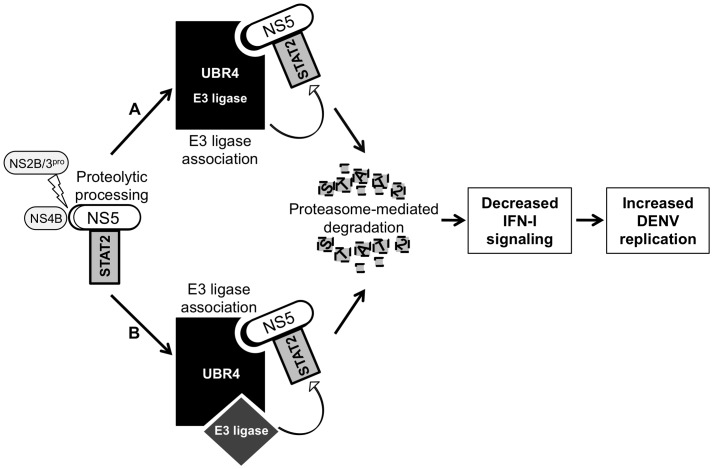
Model of DENV-mediated STAT2 degradation.NS2B/3 protease cleaves NS4B away from NS5 to yield proteolytically-processed NS5. Proteolytically-processed NS5 brings STAT2 into contact with the degradation machinery of the cell by binding UBR4. UBR4 may function as an E3 ligase (A), but as it lacks a known E3 ligase catalytic domain such as the HECT or RING, it may instead act as the recognition component or scaffold of an E3 ligase complex (B). STAT2 degradation prevents the establishment of an antiviral state thereby allowing DENV to replicate optimally.